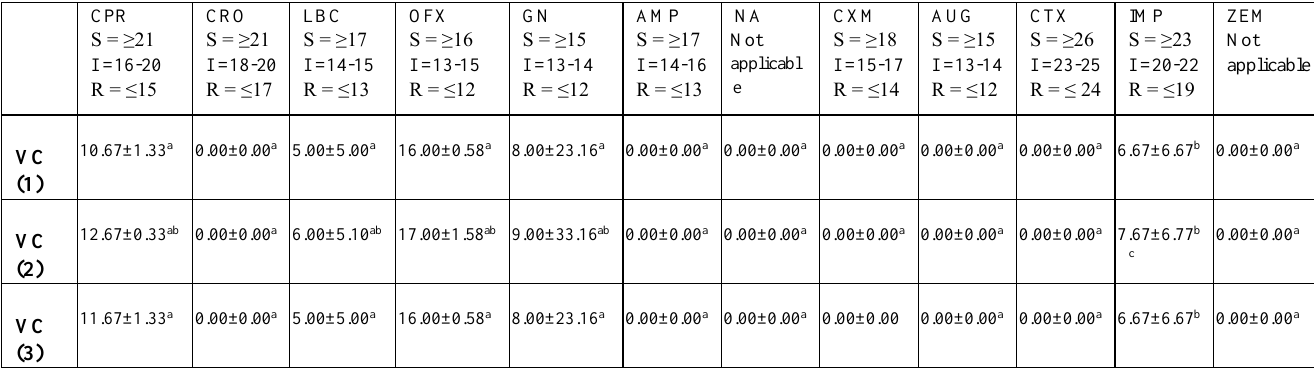
Table 2. Antibiotic sensitivity pattern of Vibrio isolates (mm).